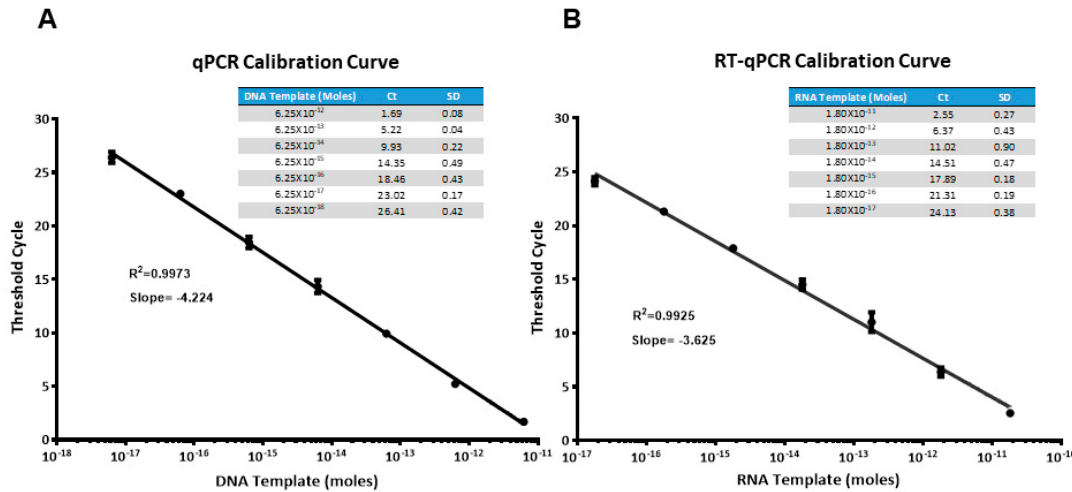
Figure 2. Calibration curves obtained for the amplification of DNA ( A ) and RNA ( B ) templates (molecules of D-ACTG and R-ACUG, respectively) using real time qPCR or RTqPCR, with SYBR green as the fluorophore. Average threshold cycle ( Ct ) of three PCR replicas for each template concentration is shown in the table inset.